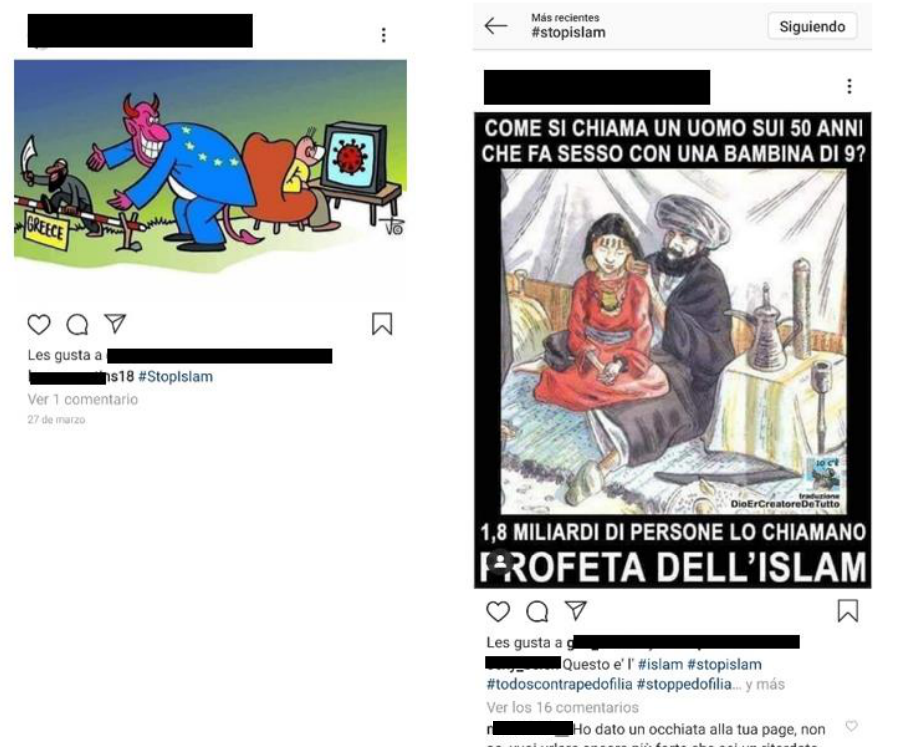
Figure 5. Examples from the category Muslims should be deported and Muslims as rapists. Caption: What is the name of a man who with 50 years has as a partner a girl of 9? 1.8 million people call him the prophet Muhammad.